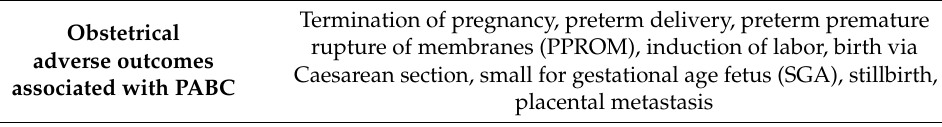
Table 3. Adverse obstetrical, fetal, and neonatal outcomes associated with the diagnosis and treatment of